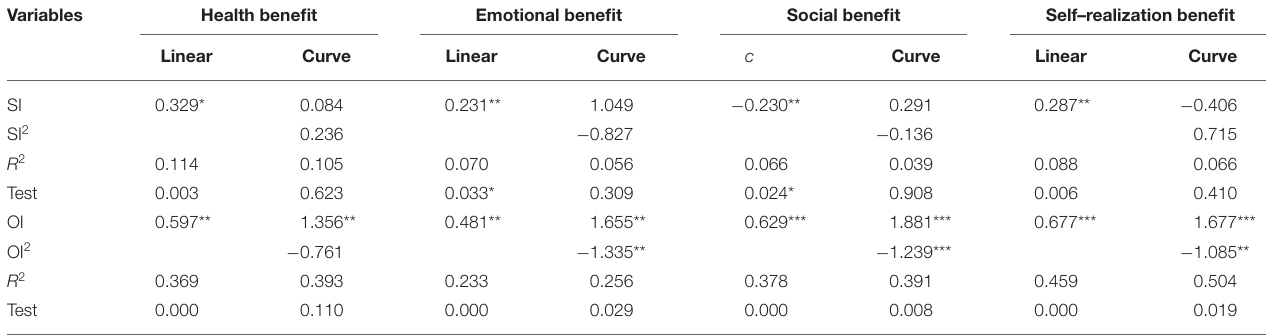
TABLE 3 | The impact of degrees of leisure involvement on physiological and hedonistic leisure. Variables Health benefit Emotional benefit Social benefit Self–realization benefit Linear Curve Linear Curve c Curve Linear Curve